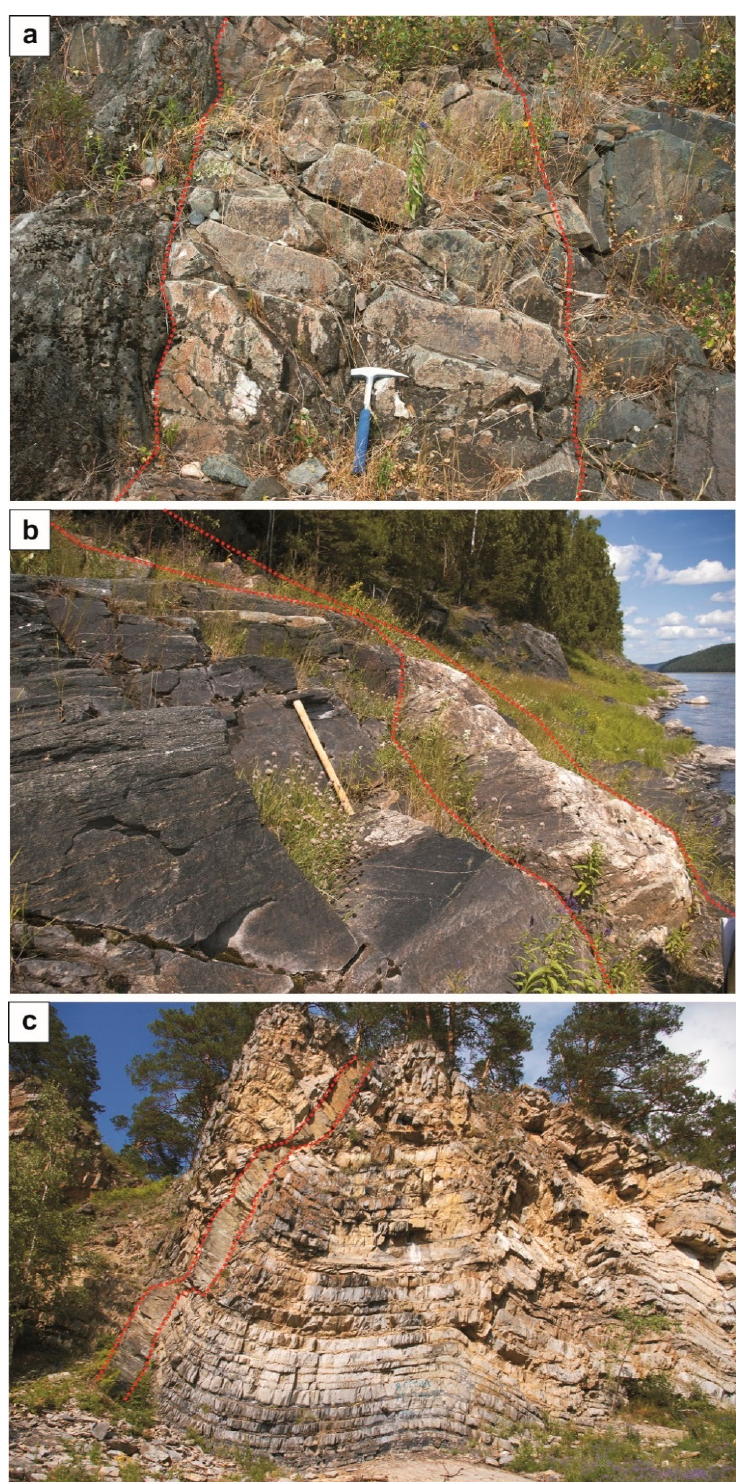
Figure 3. Photographs of some of the studied dikes: ( a )—quartz diorite dike A09-11; ( b )—leucocratic granite dike M08-3; ( c )—one of the dolerite dikes.